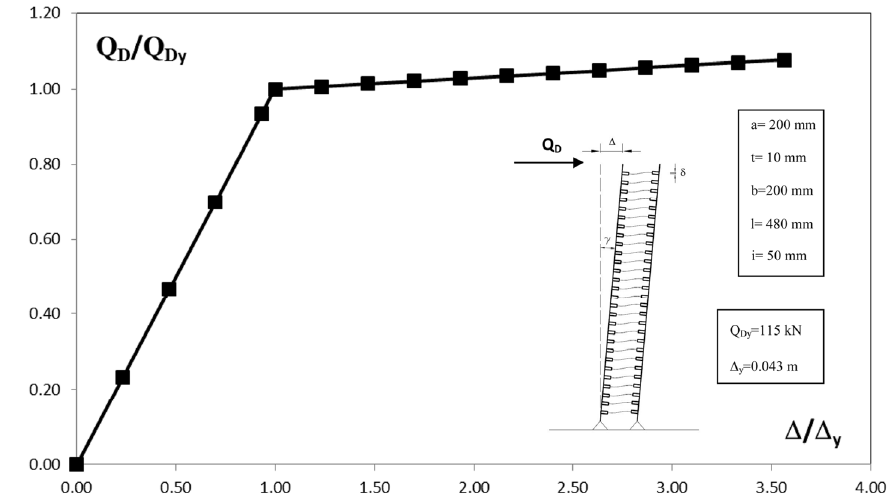
Figure 3. Model A: Theoretical force-displacement relationship.